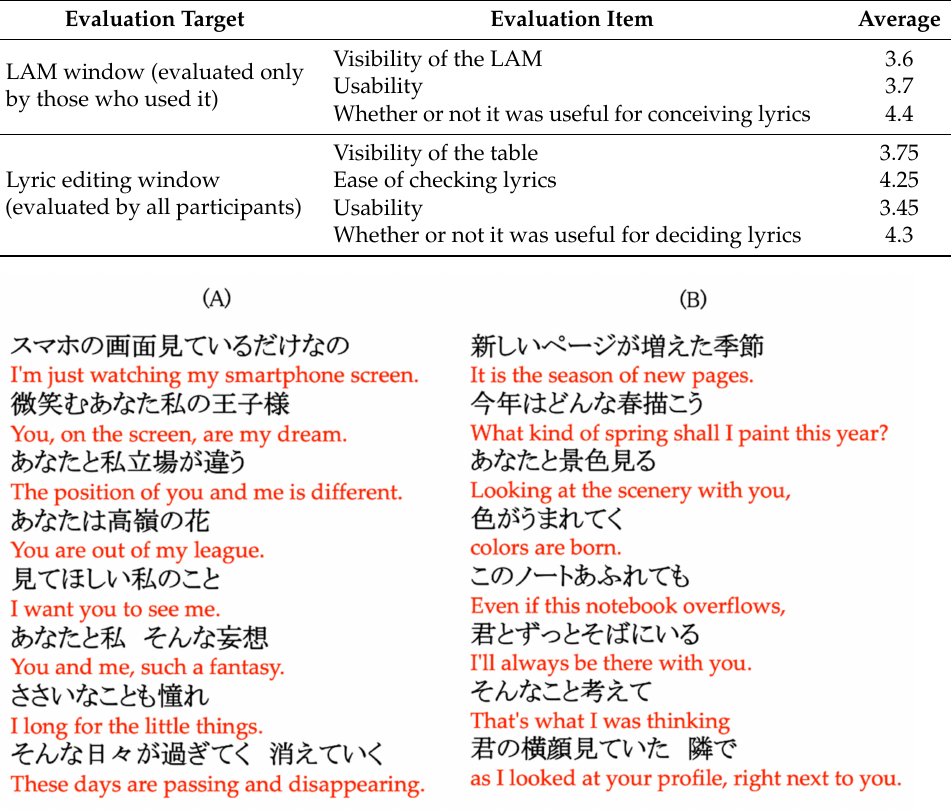
Figure 4. ( A ) Lyrics created by participants C and D (collaboration and LAM use group). ( B ) Lyrics created by participants G and H (collaboration and LAM non-use group). The black texts are the Japanese lyrics created by participants. The authors added the English translations of the Japanese lyrics in